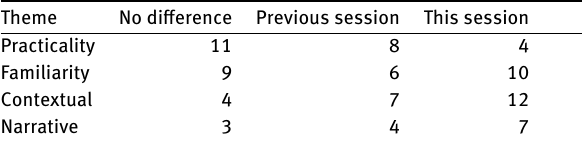
Table 13: Referenced Theme and Preferences.